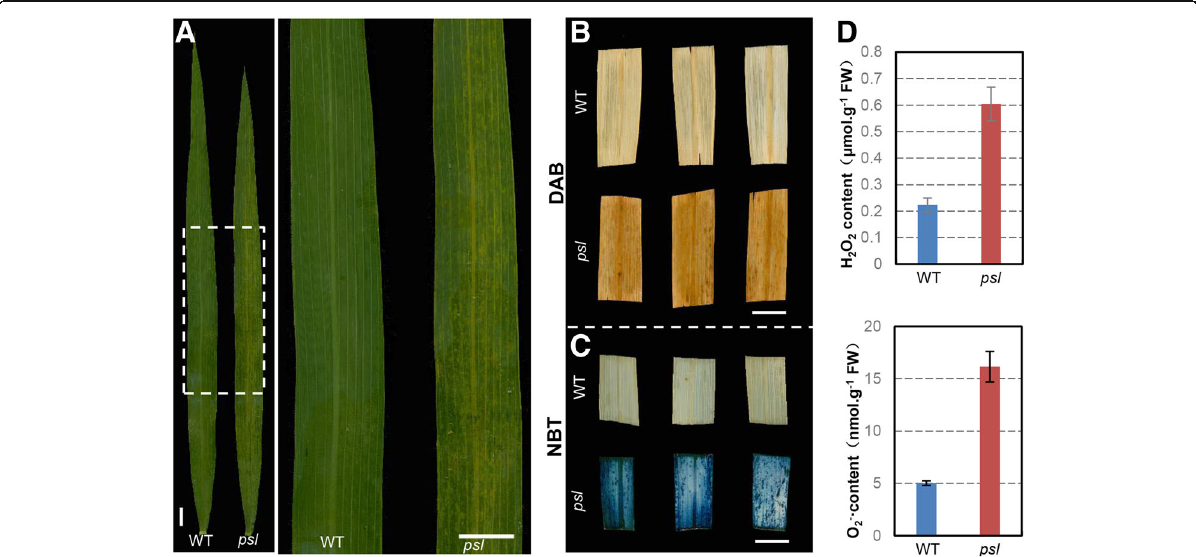
Fig. 2 Comparison of ROS levels between wild-type and psl plants. a phenotype of flag leaves two days after flowering. b Leaves stained with 3,3 ′ -diaminobenzidine (DAB), showing the H 2 O 2 levels in wild-type (WT) and psl plants . c Leaves stained with nitroblue tetrazolium (NBT), showing O